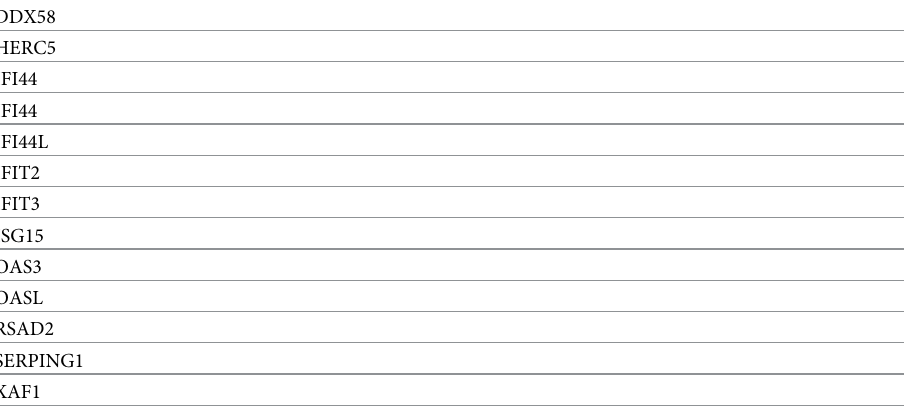
Table 2. Overlap of HCV genes with the pan-viral